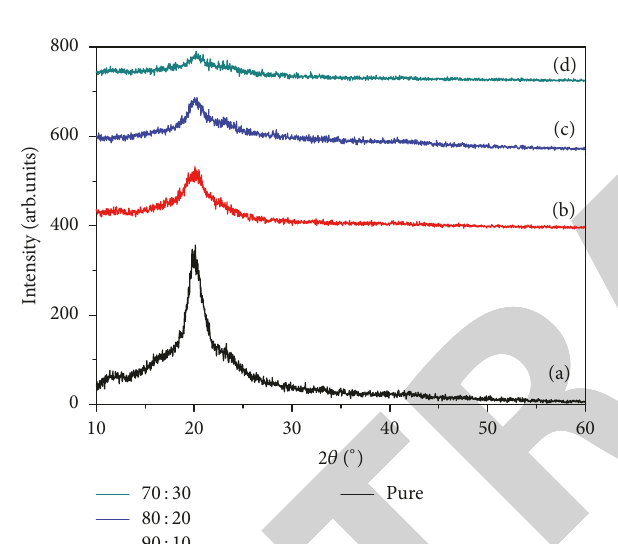
Figure1:XRDpatternfordifferentwt%ratiosofcompositepolymer electrolyte